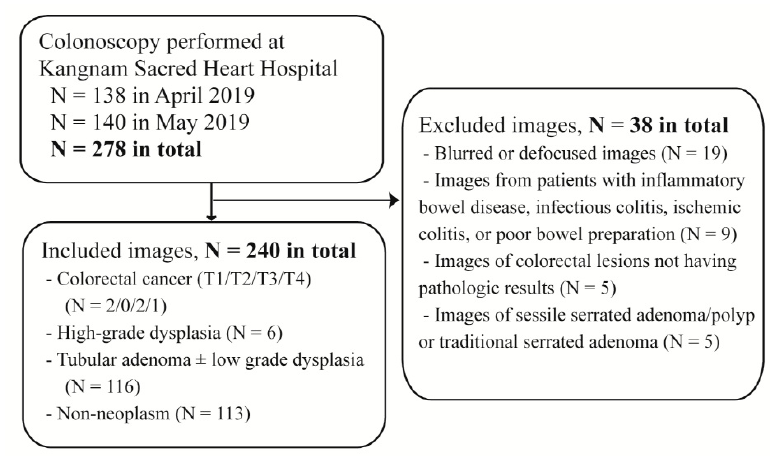
Figure 1. Flow diagram of the external validation procedure.